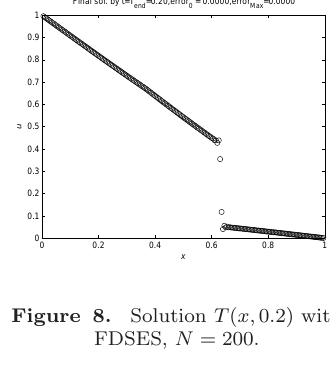
Figure 7. Solution T ( x, 0 . 2) with FDS, N = 200.